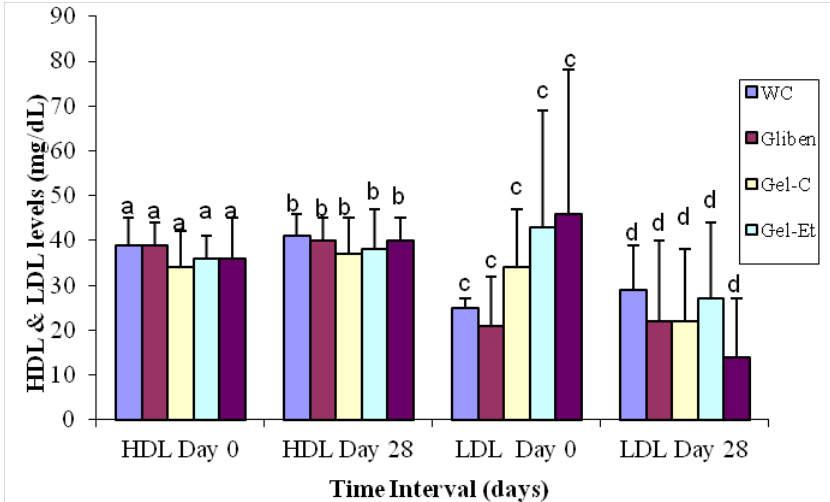
Figure 3. Effects of different treatments on the serum HDL and LDL levels of type 2 diabetic model